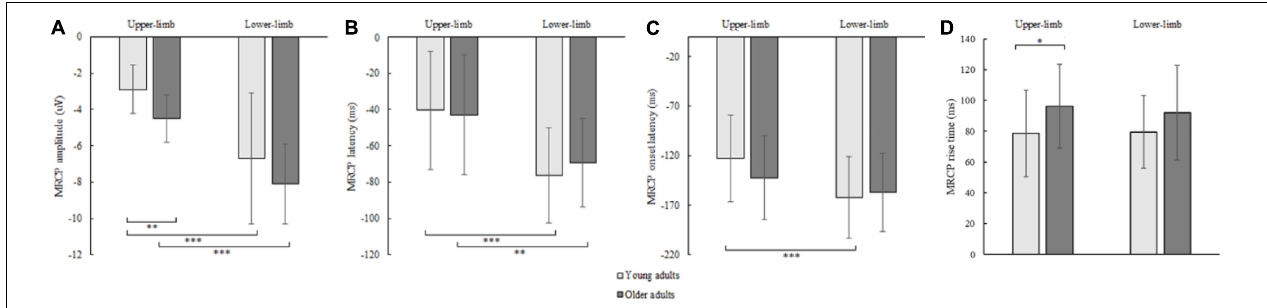
FIGURE 7 | MRCP peak amplitude (A) , peak latency (B) , onset latency (C) , and rise time (D) of younger and older adults for lower- and upper-limb conditions. Error bars reflect one SD. ∗ represents p < 0.05; ∗∗ represents p < 0.01; ∗∗∗ represents p <